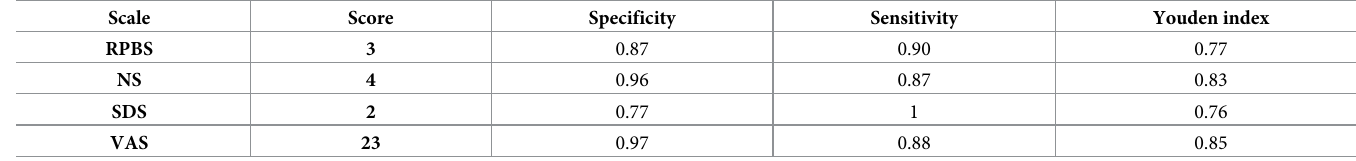
Table 11. Scores, specificity, sensitivity, and Youden index corresponding toindication for rescue analgesia of the RPBS and unidimensional scales. Scale